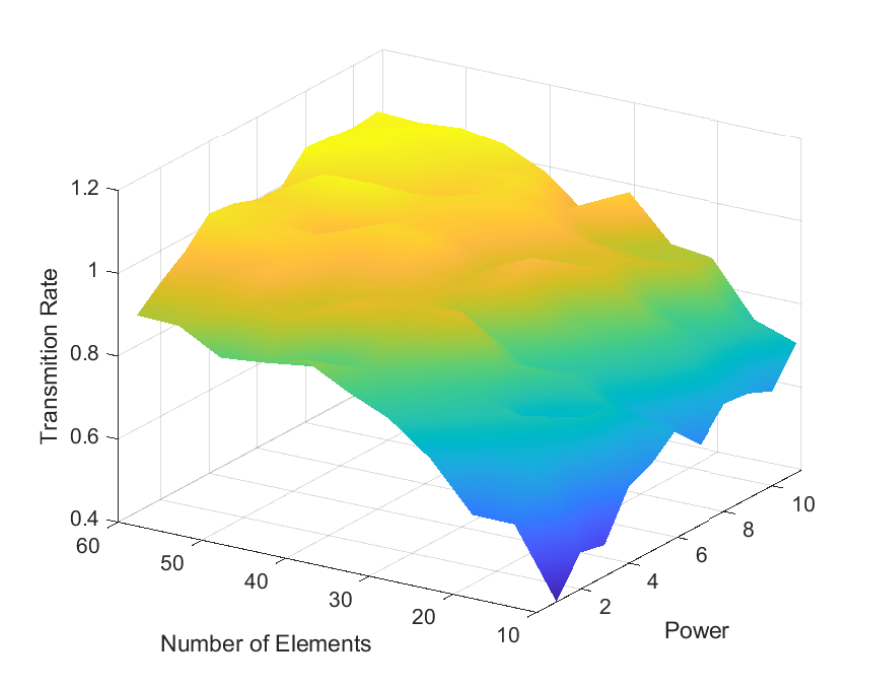
Figure 4. Maximum secure transmission rate with the power and the number of